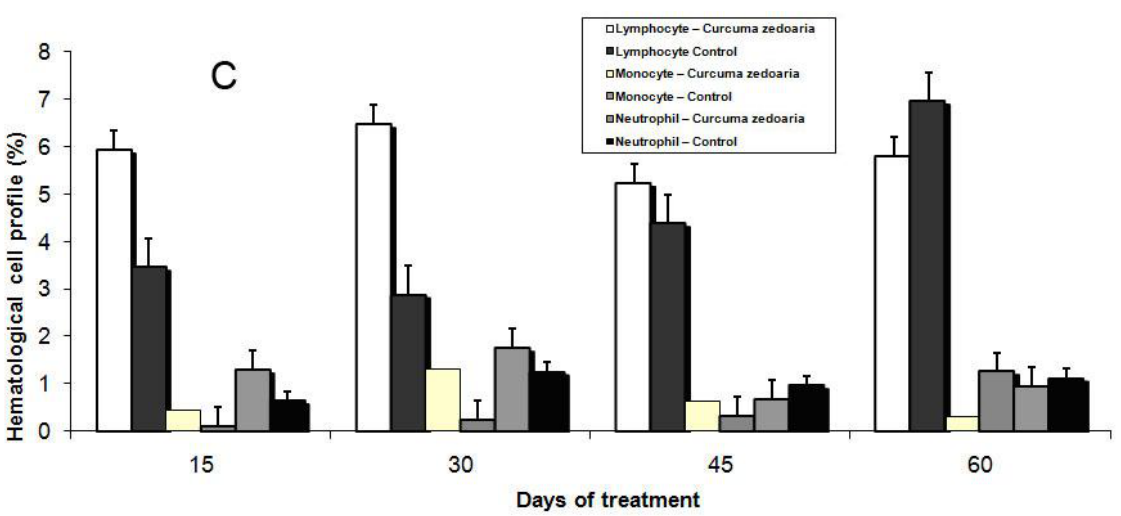
Figure 3. Differential analysis of leukocytes in the blood of C57BL/6J mice treated with ( A ) 0.1%; ( B ) 0.2% or ( C ) 1% Curcuma zedoaria crude extract. Data are expressed as mean ±